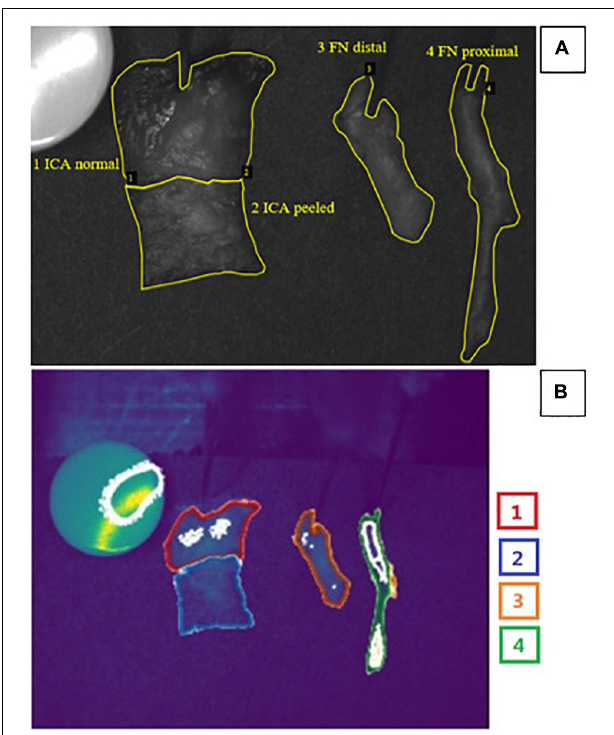
FIGURE 1 | (A) Example of a grayscale image for spectral bands at 555 nm used for annotations of measured ex vivo tissues made by an ENT specialist. Manually classified area from tissues (Jacques, 1996; Richards-Kortum and Sevick-Muraca, 1996; Fujimoto et al., 2000; Hadjipanayis et al., 2015) was used as a ground truth. (B) Automatic segmentation results for corresponding example obtained via the combination of U-Net convolutional neural network and preselected optimal spectral bands. Color of the borders corresponds to tissue types: red, ICA normal; blue, ICA peeled; orange, FN distal; and green, FN proximal. Of the pixels 90.93% were classified correctly. Grainy white parts of the image represent noise. Abbreviations: ICA, internal carotid artery; FN, facial